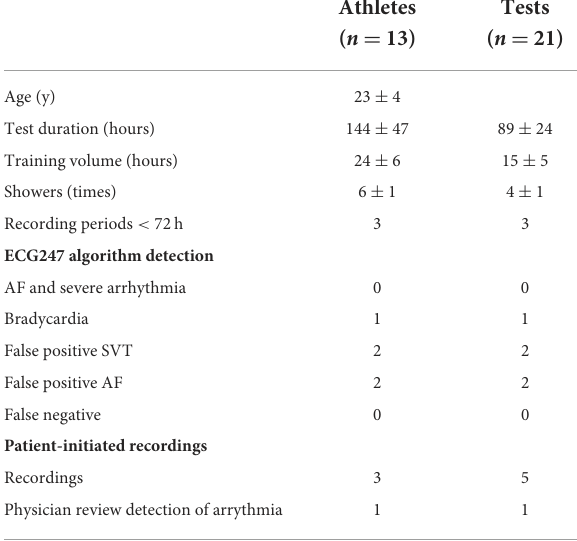
TABLE 2 Characteristics and diagnostic evaluation for the field